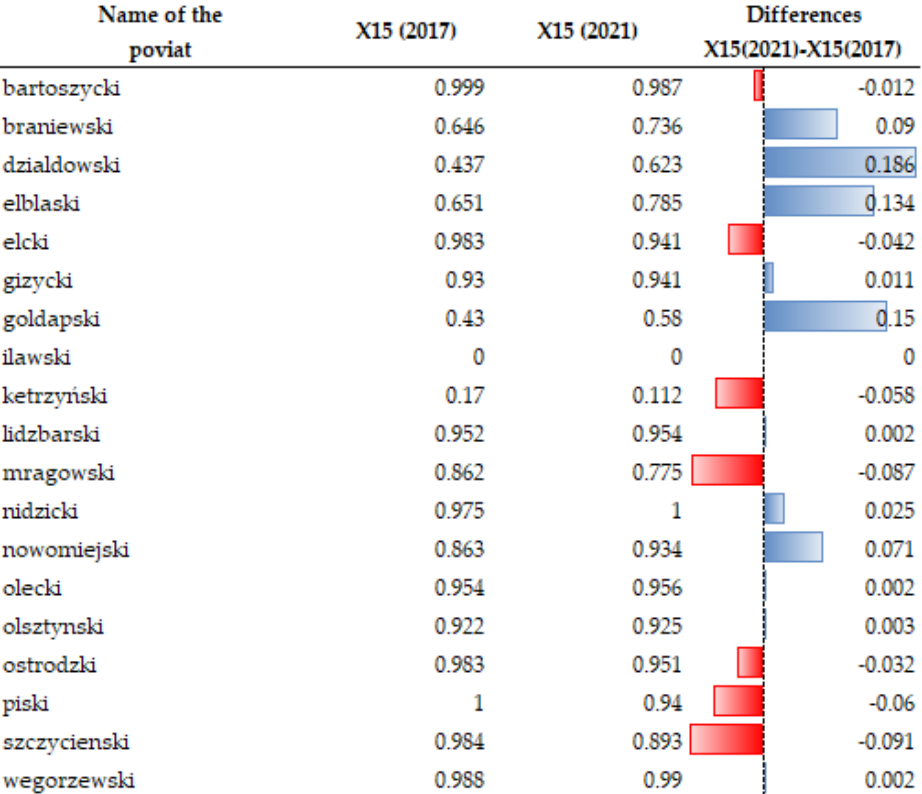
Figure 4. Changes in the index of green energy production (X15) in 2017–2021. Source: own study on [103].